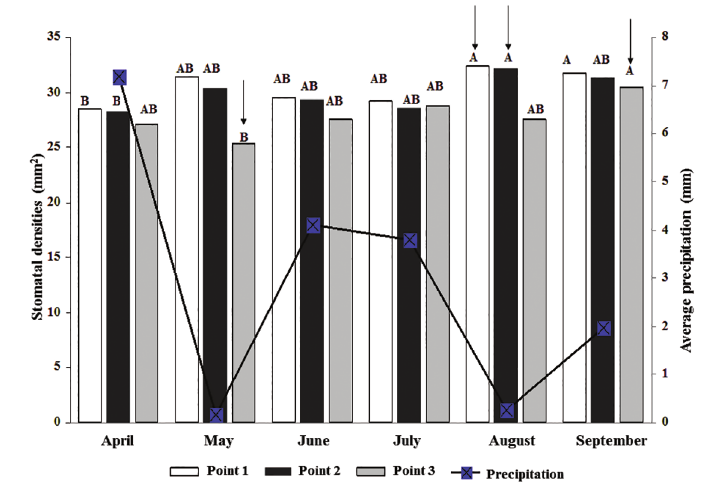
Fig. 3 - Average precipitation (mm) and the stomatal density of Tradescantia pallida leaves collected at the three sampling points during different periods of the year. (The averages of each point followed by the same letter did not differ significantly at the different collection times according to the Tukey test at a 5% level of probability). Arrows indicate the periods of less rainfall.